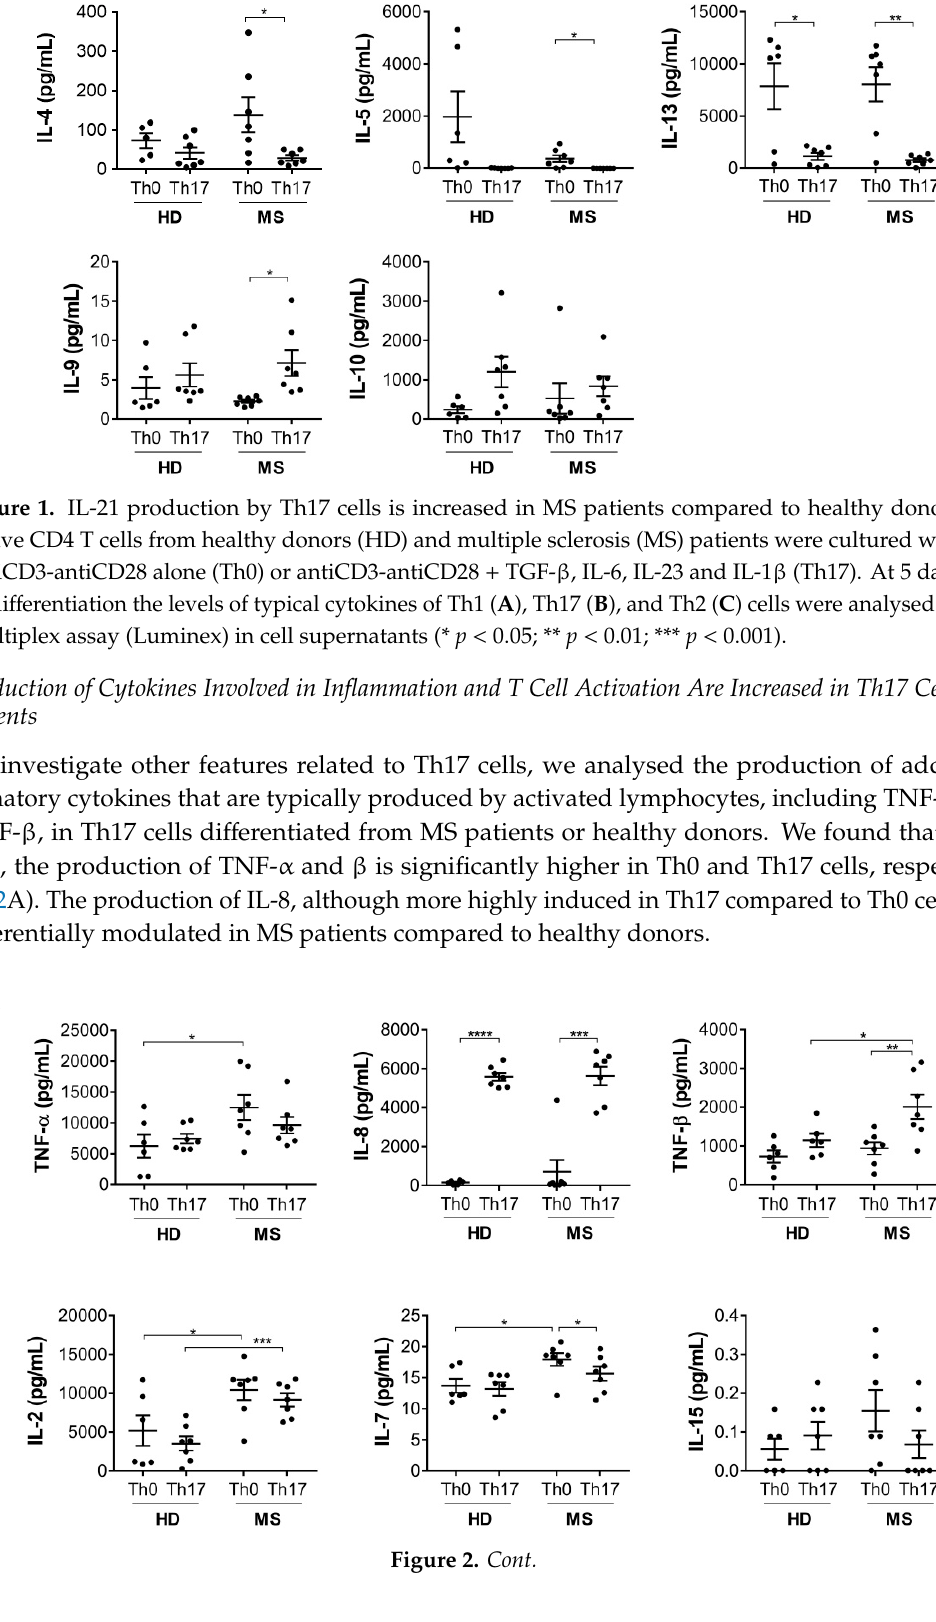
Figure 2. Production of cytokines involved in inflammation and T cell activation are increased in Th17 cells from MS patients. Naive CD4 T cells from healthy donors (HD) and multiple sclerosis (MS) patients were cultured with antiCD3-antiCD28 alone (Th0) or antiCD3-antiCD28 + TGF- β , IL-6, IL-23 and IL-1 β (Th17). At 5 days of differentiation the levels of inflammatory cytokines ( A ), cytokines involved in T cell expansion ( B ), and growth factors ( C ) were analysed by multiplex assay (Luminex) in cell supernatants (* p < 0.05; ** p < 0.01; *** p < 0.001; **** p < 0.0001).